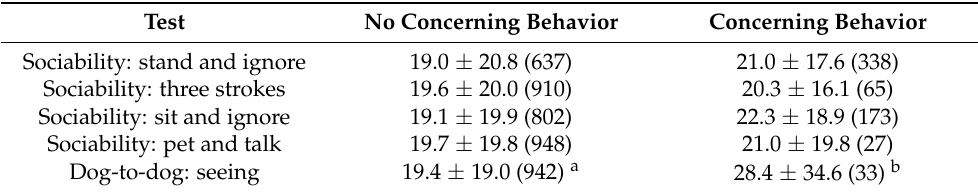
Table 5. Length of stay (mean ± SD , in days) for dogs in relation to behavior shown during the four subtests of the Sociability test and the seeing subtest of the Dog-to-dog test. Number of dogs shown in parentheses. Within rows, values with different superscript letters are significantly different 1